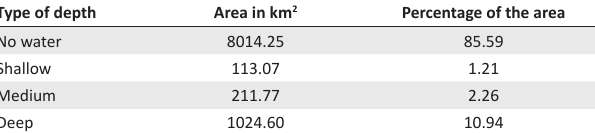
TABLE 4: Type of floodwater depth and occupied